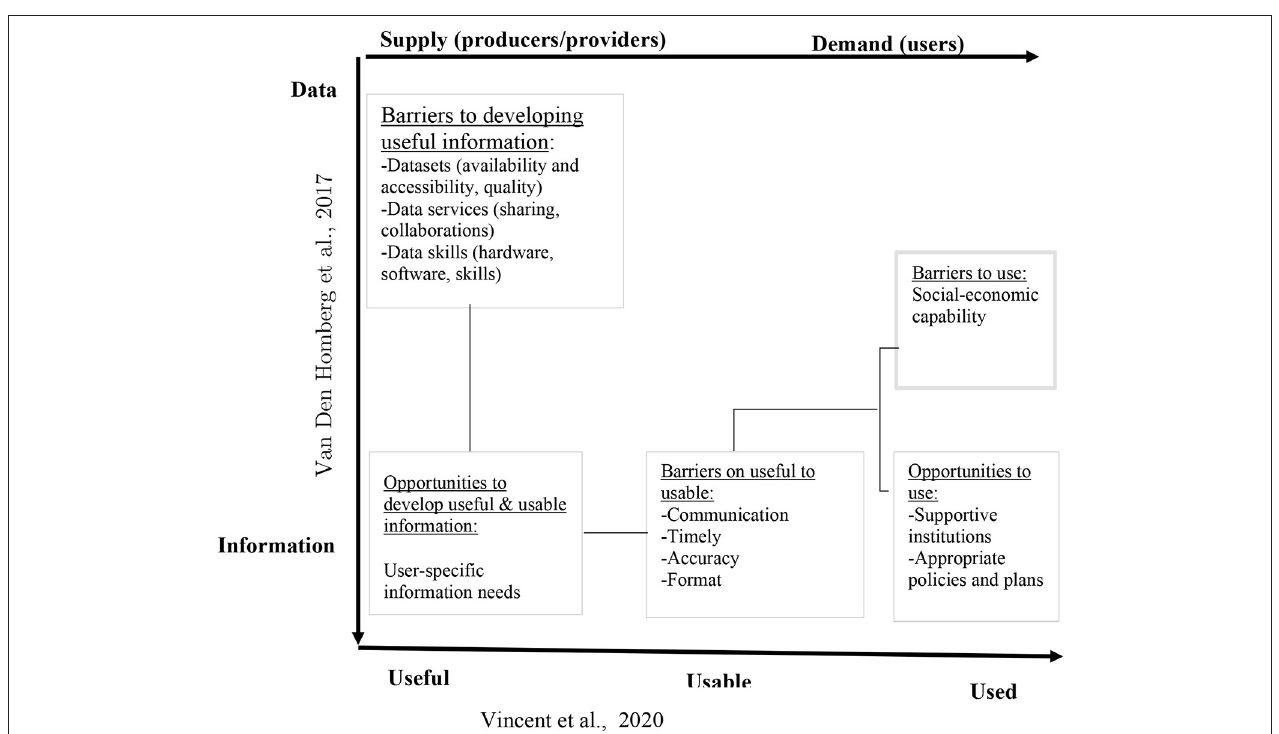
FIGURE 1 | Conceptual framework used to identify the barriers and opportunities in the production/provision and use of WCI across the provider-user landscapes. Source: adapted from Vincent et al. (2020) and Van Den Homberg et al. (2017) and modified by authors.